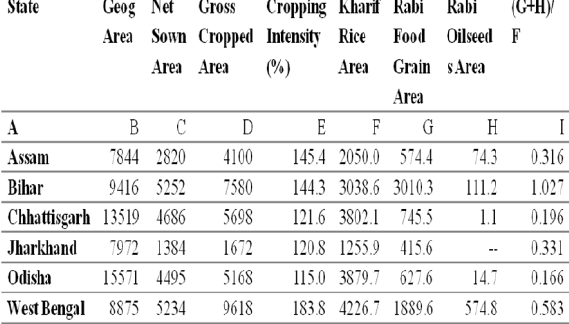
The main reasons for ‘rice fallows’ include [Chandna,